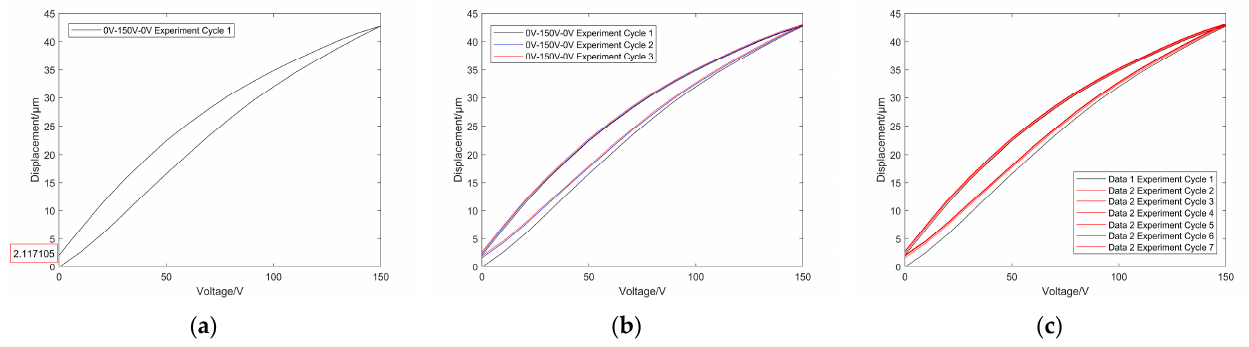
Figure 5. Experimental voltage-displacement curves: ( a ) voltage-displacement curve of the first cycle after start-up; ( b ) voltage-displacement curve of the first three cycles; ( c ) voltage-displacement curve of the first seven cycles.